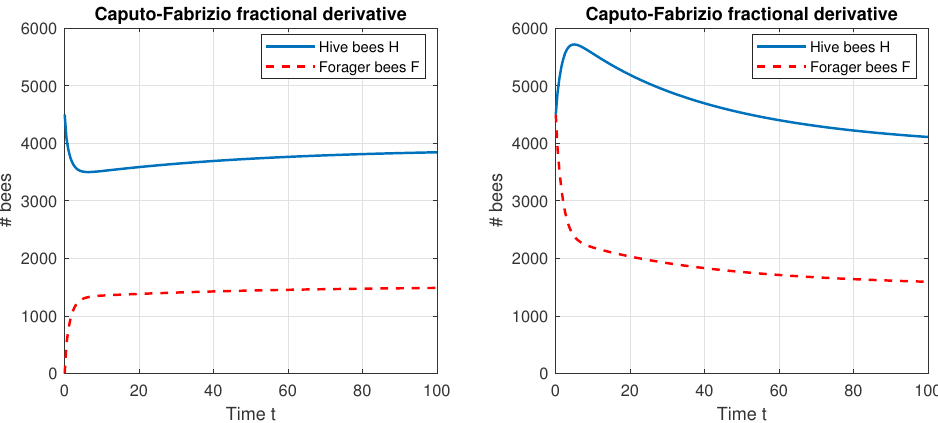
Figure 2. The colony population size for H 0 = 4500: F 0 = 0 ( left ), F 0 = 4500 ( right ), modeled by the Caputo–Fabrizio derivative